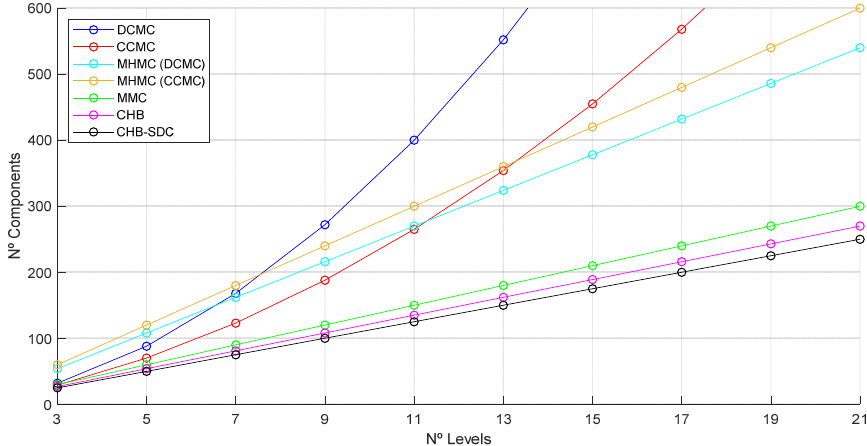
Figure 1. Elements quantities comparison required for each multilevel converter according to the number of levels. number of